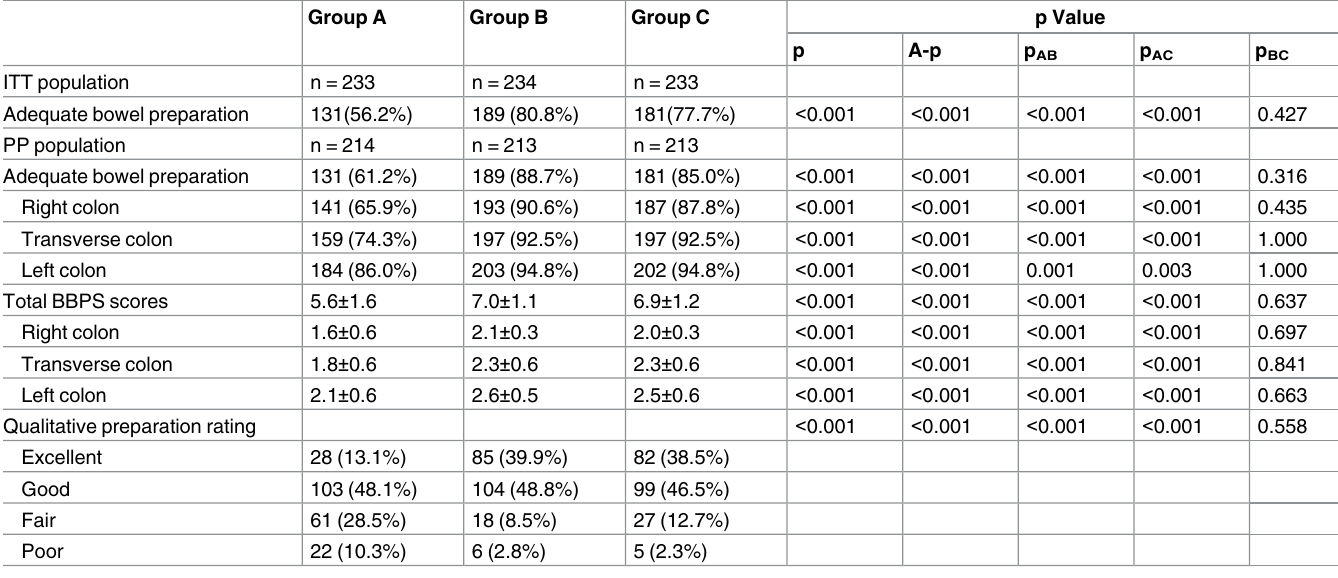
Table 2. Bowel preparation quality in 3 groups in intention to treat (ITT) analysis and per-protocol (PP) analysis. Group